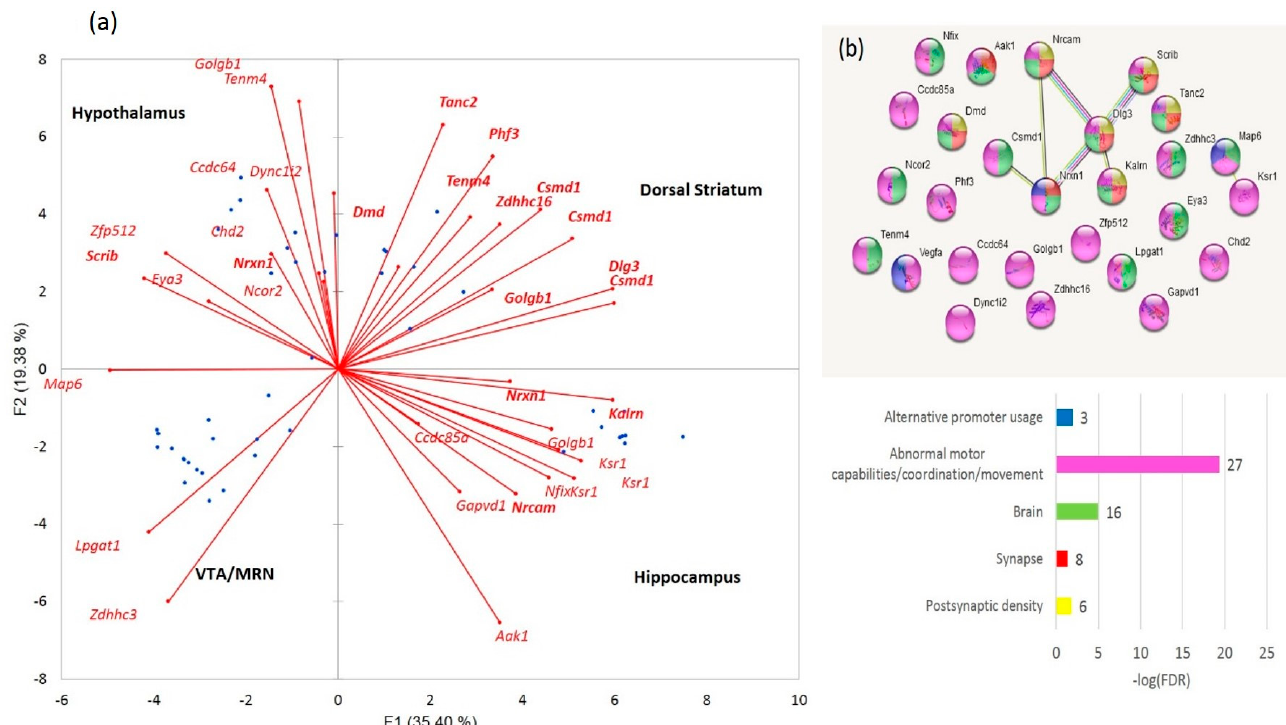
Figure 9. ( a ). Elucidation of eight DS-specific DAS ES genes ( Tanc2 , Csmd1 , Phf3 , Dlg3 , Tenm4 , Zdhhc16 , Dmd , and Golgb1 ) from the 27 analyzed using our earlier published data on five brain regions [10]. ( b ). Explicit GO annotation of the 27 gene cluster (GO: MP:0002066; ‘Abnormal motor capabilities/coordination/movement’). VTA is the ventral tegmental area and MRN, midbrain raphe nuclei.